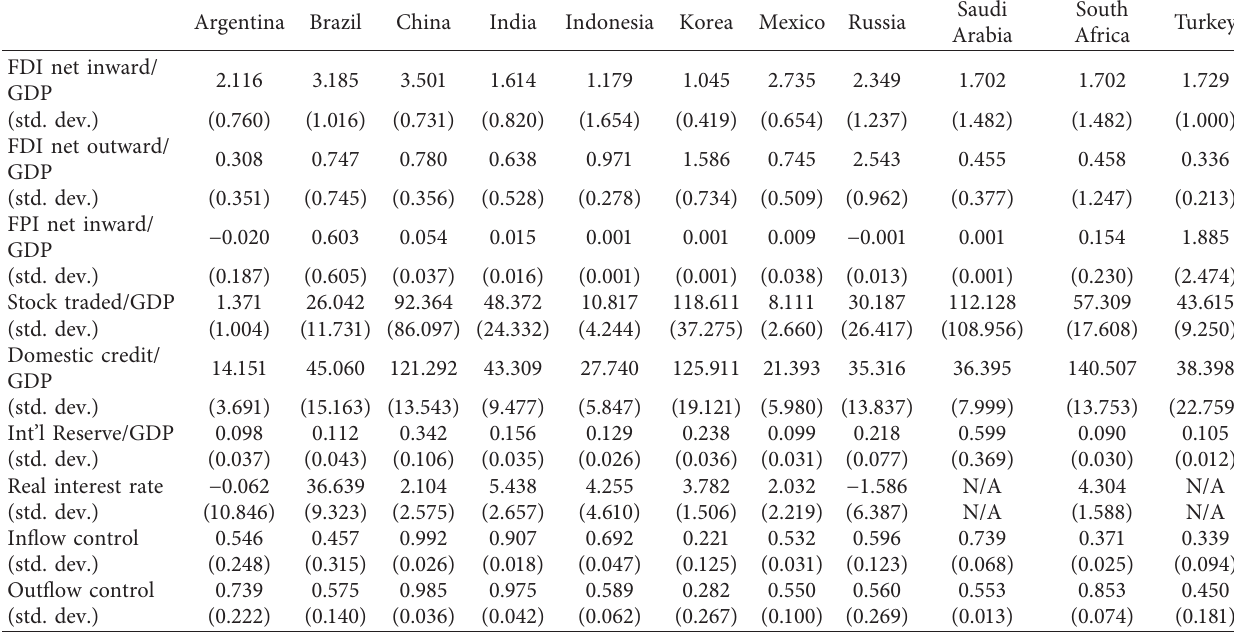
Table 1: Descriptive statistics in eleven emerging countries.